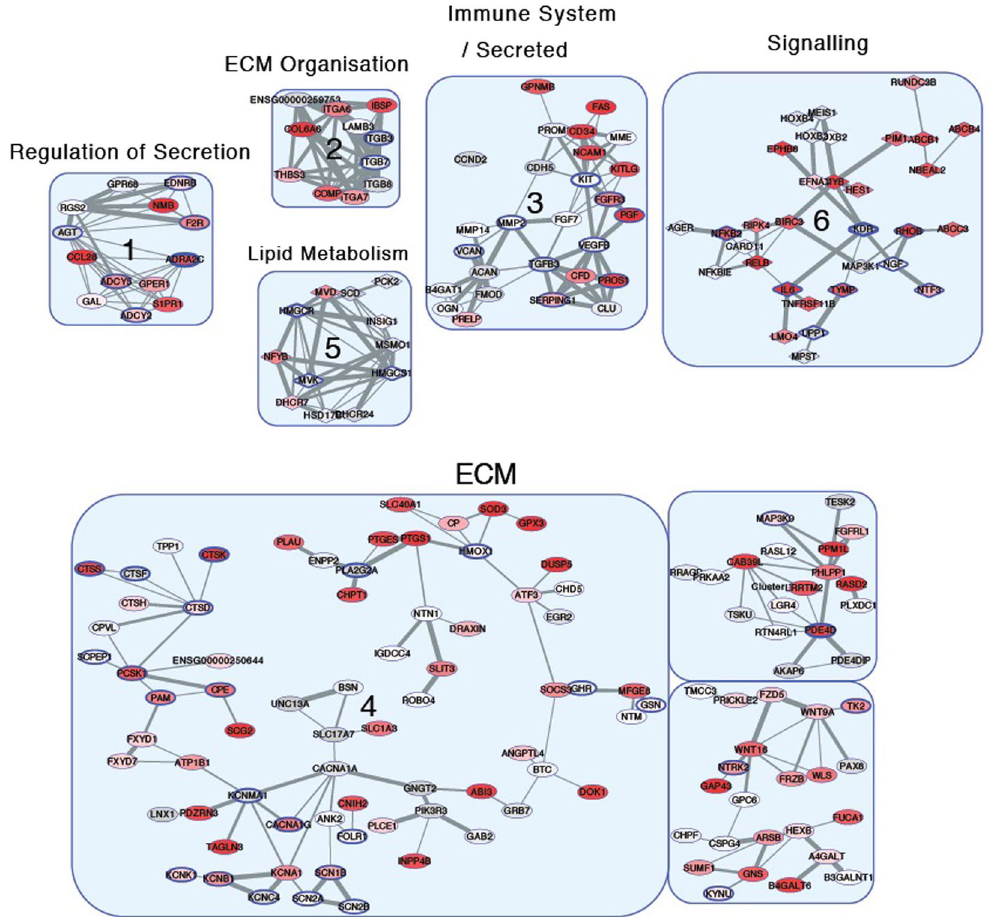
Figure 4. High-level modules were identified by a network clustering algorithm (see methods) using the STRING network data. Redness-fill of a node corresponds to the adjusted p value from the RNA-Seq analysis (redder nodes have lower p values). Diamonds correspond to upregulated genes whilst ellipses correspond to downregulated genes in FFs compared to NFs. The thickness of the node boundary corresponds to the number of drugs available to bind the protein. The GO term most strongly associated with the cluster is shown in the label. ECM = Extracellular matrix.